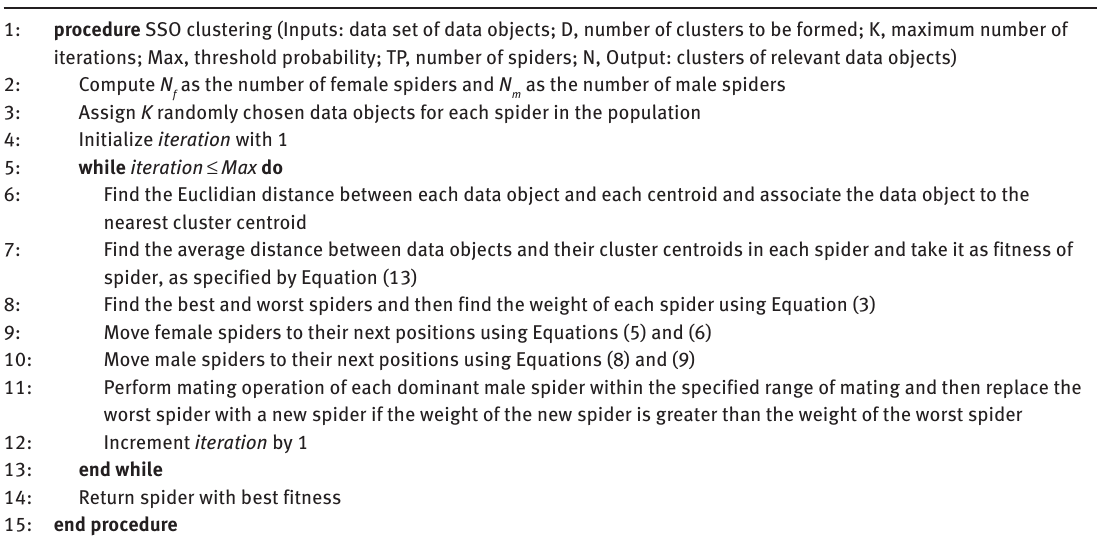
Algorithm 1: SSO data clustering